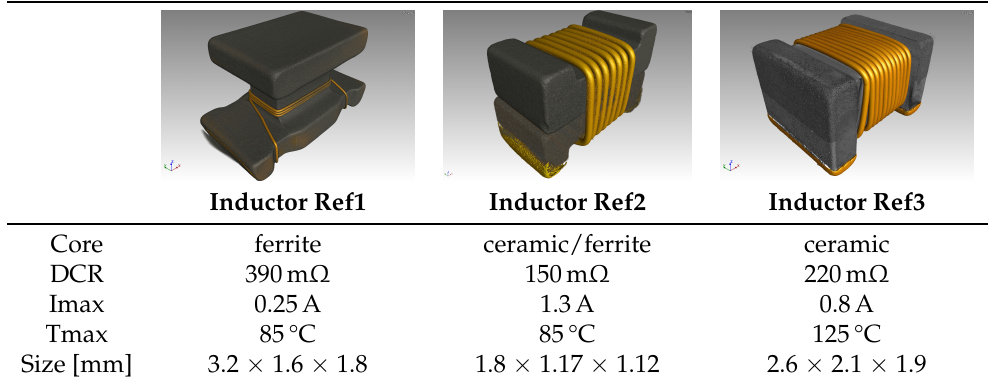
Table 1. Reference inductors.